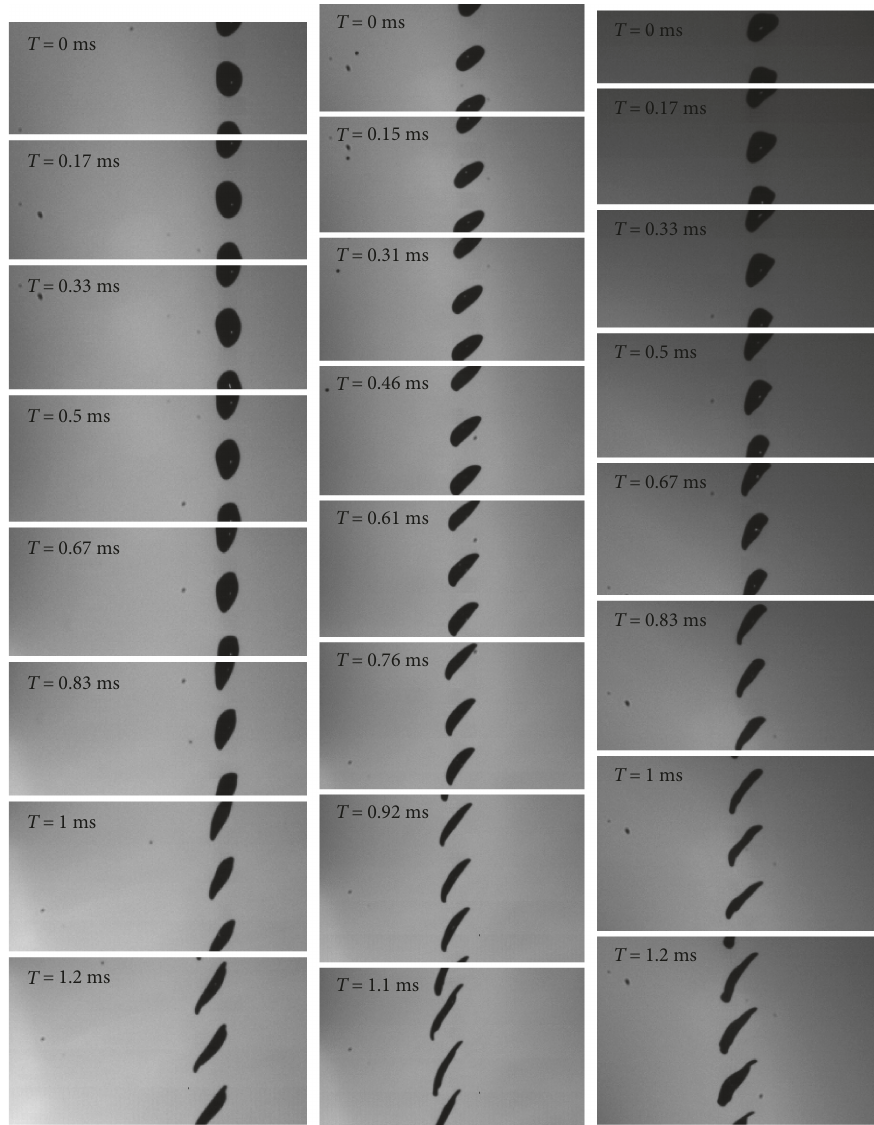
Figure 14: Recorded droplet evolution for cases #7 (left), #8 (centre), and #9